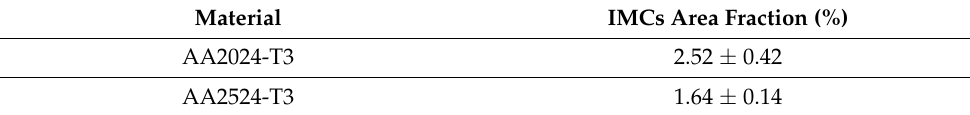
Table 3. Comparison of IMCs area fraction of AA2024 and AA2524